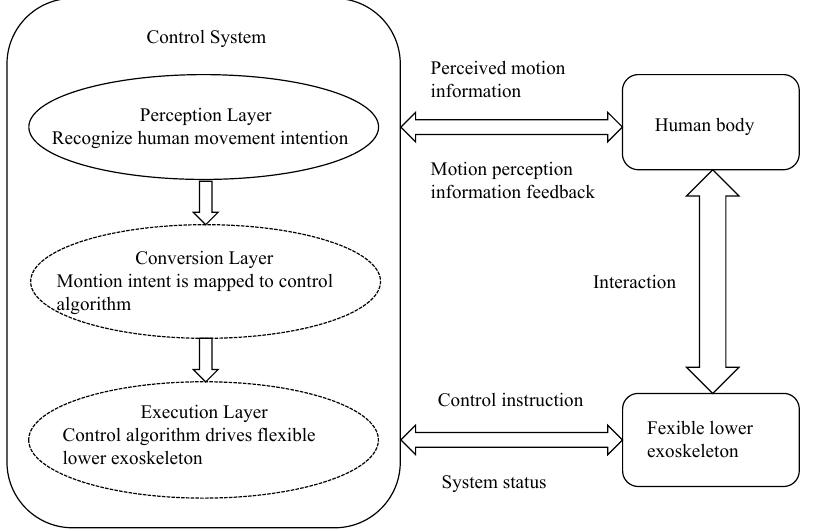
Figure 2. Control strategy of flexible